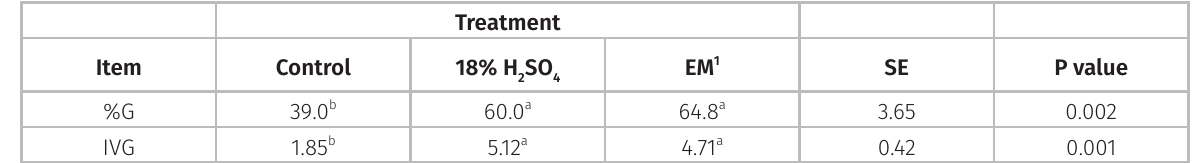
Table V. Percentage of germination (%G) and germination speed index (IVG) of palisade grass seeds treated with sulfuric acid and